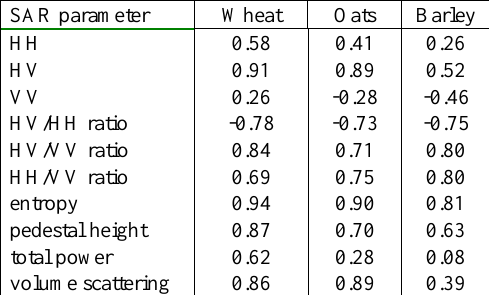
Table 2. Correlation coefficients (R) between RADARSAT-2 response and optically derived LAI